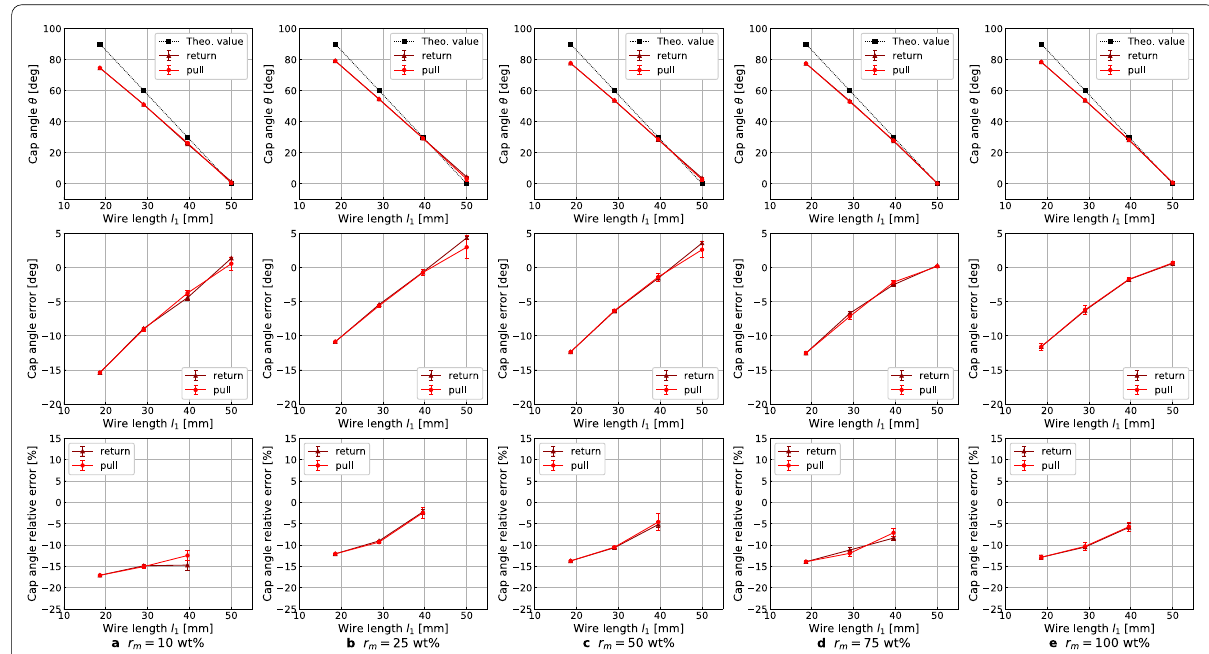
Fig. 10 Cap angle θ (top), its error (middle), and relative error (bottom) to wire length l 1 for each plasticizer mixing ratio in deformation pattern (a). Each plot represents the mean value of the three times. The error bars represent the standard deviation